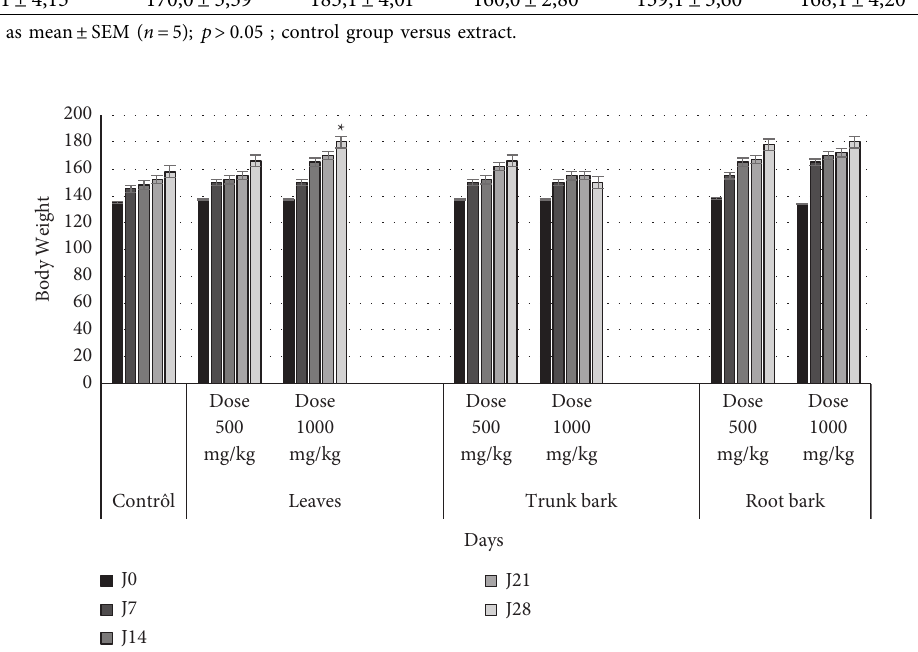
Figure 1: Effects of the hydroethanolic extract of the parts of P. santalinoides leaves on the evolution of rat